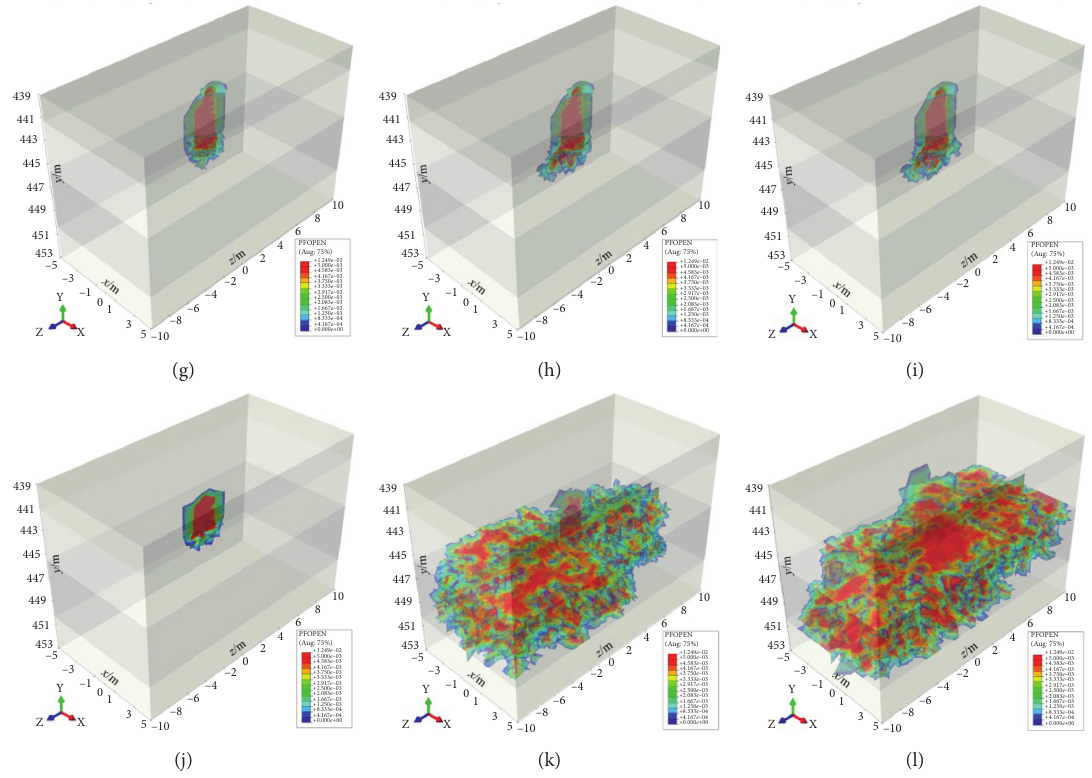
Figure 10: Numerical simulation results of indirect fracturing coal technology. (a) HFs opening ( D